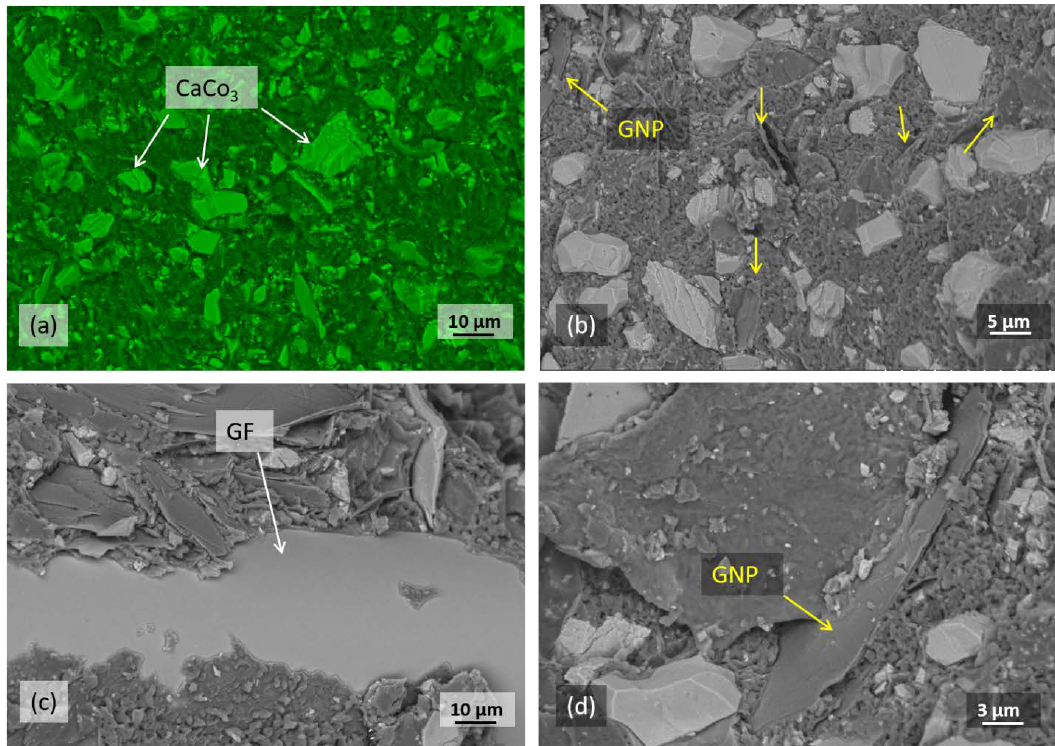
Figure 6. SEM (scanning electron microscopy) images of the composites; ( a ) blend of polyester and CaCO 3 , ( b ) the same blend mixed with 5 wt.% GNP, ( c ) GF-reinforced mixture and ( d ) interfacial adhesion between resin and GNP. Backscattering electron signals were employed to help us to differentiate between CaCO 3 and GNP.